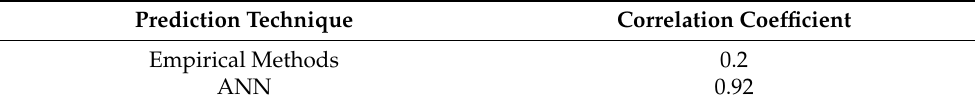
Table 2. Comparison of correlation coefficient value of empirical method and ANN models [71].